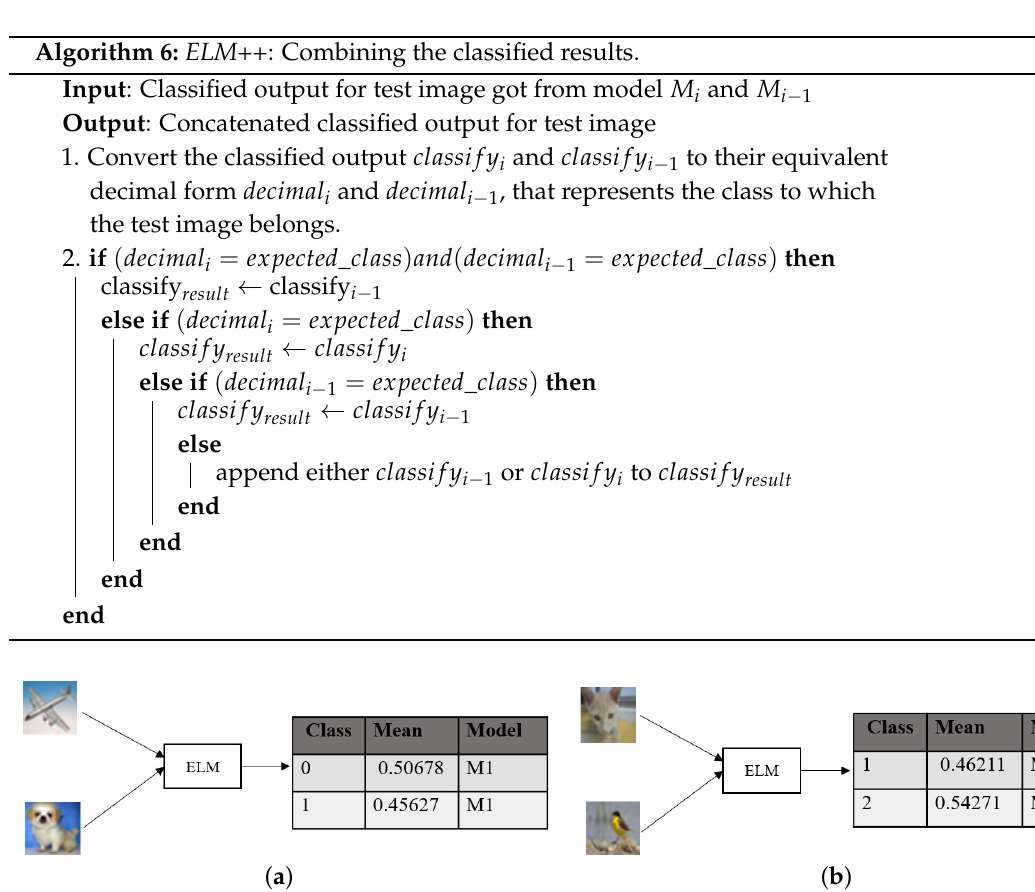
Figure 8. Models created for each train set - (a) creates a model M1 for batch A and (b) creates a model M2 for batch B.